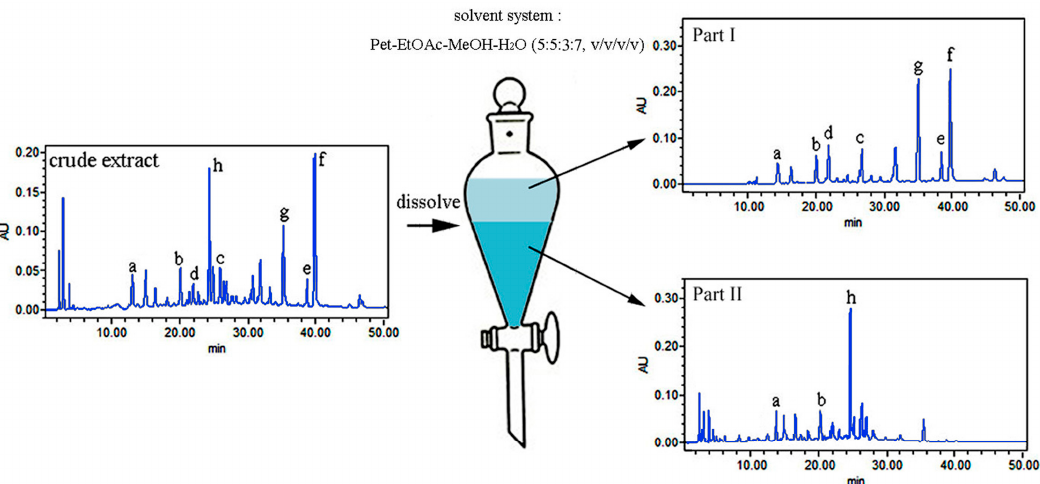
Figure 2. HPLC chromatograms of part I, part II, and the Chimonanthus praecox flower (CPF) extract. Pet: petroleum ether; EtOAc: ethyl acetate; MeOH: methanol. a . 3,4-dihydroxy benzoic acid,